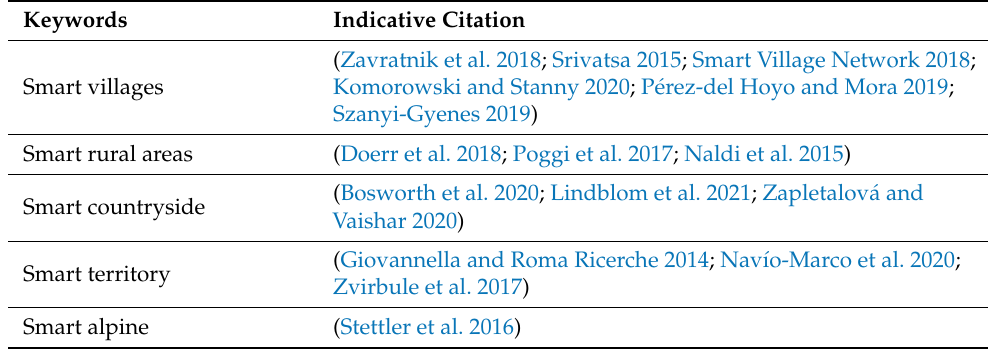
Table 2. Main keywords used in the literature search.